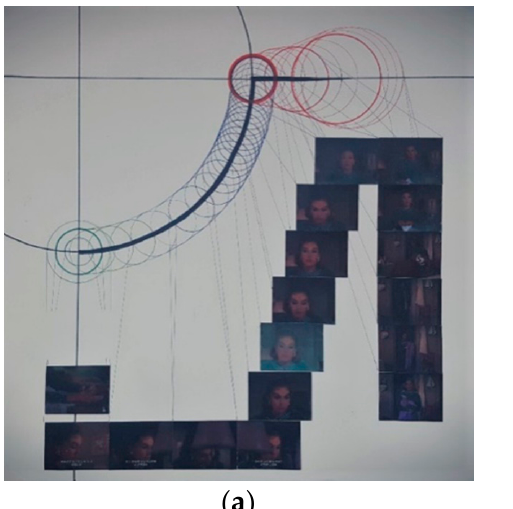
Figure 5. Various synthetic drawings of students’ designs. Based on the synthetic drawings conducted as part of the Visual Communication De- sign Studio, we found that the use of filmic spaces for translation into architectural spaces could create unique architectural drawings because the filmic spaces, by developing pro- jects beyond students’ limits of expression, could become novel venues for students to produce unusual ideas. Not a single student synthesized the drawings in the same way, which suggests that the students performed inferential thinking to produce diverse ideas